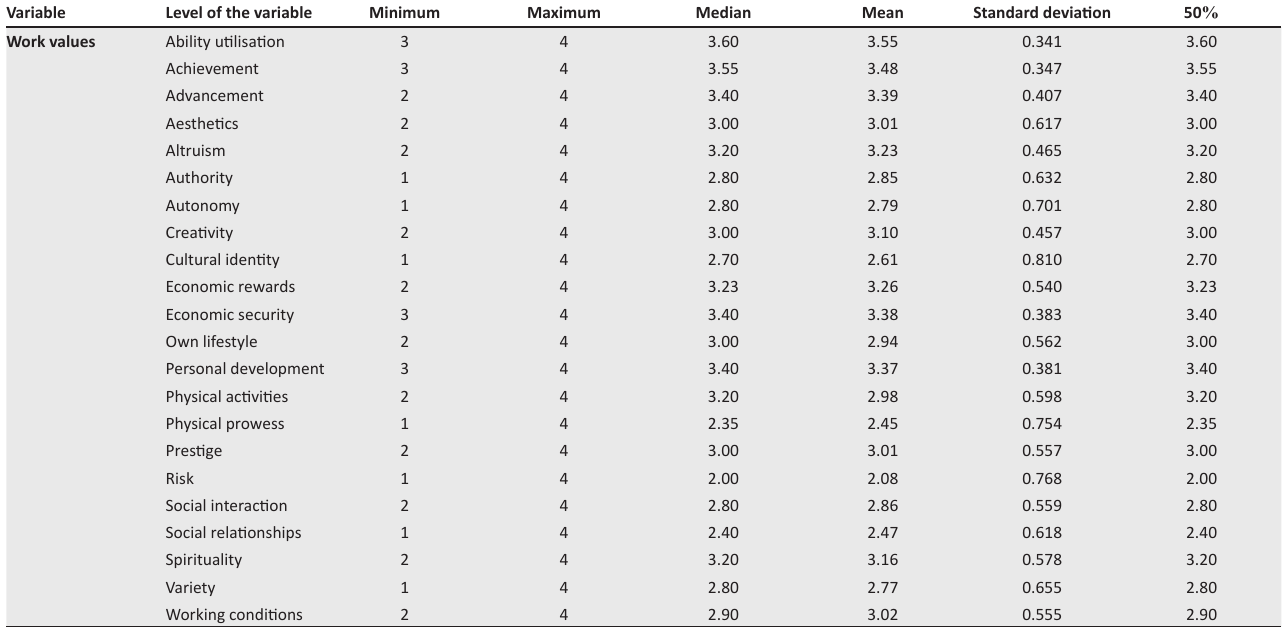
TABLE 3: Measures of central tendency for the Baby Boomer cohort with regard to work values. Variable Level of the variable